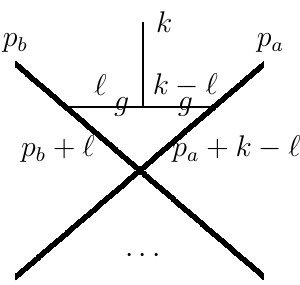
Figure 3 . A pictorial representation of (3.41). The internal thin lines marked by g represent the retarded graviton propagators G r ( ‘ ) and G r ( k (cid:0) ‘ ) respectively. The vertex where the three thin lines meet is proportional to F (cid:22)(cid:23);(cid:11)(cid:12);(cid:26)(cid:27) , encoding the contribution to the stress tensor due to the gravitational (cid:12)eld, and the vertices where the internal gravitons meet the thick lines correspond to the leading contribution to the trace reversed stress tensors of these particles, proportional to p (cid:22) p (cid:23) (cid:0) p 2 (cid:17) (cid:22)(cid:23) = 2 and p (cid:22) p (cid:23) (cid:0) p 2 (cid:17) (cid:22)(cid:23) = 2 respectively. a a a b b b we have de(cid:12)ned 8 (cid:25) G T h(cid:22)(cid:23) as the collection of the quadratic terms in the expansion